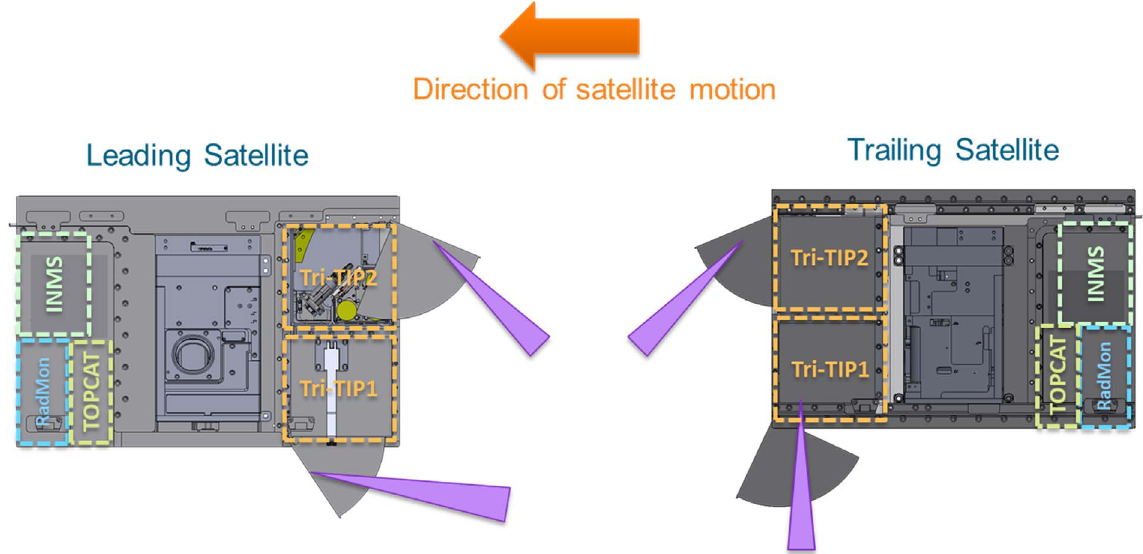
Fig. 5. Schematic layout of the CIRCE payloads within the lead and trail satellite buses. The UK ’ s IRIS suite of payloads occupies the front 2U of the leading satellite, and during night-time, the rear of the trailing satellite. The bus avionics are located in the centre 2U of each bus. The US Tri-TIP payloads occupy the rear 2U of the leading satellite, and during night-time, the front of the trailing satellite. This enables the Tri-TIP instruments to image the same volume of the ionosphere to support tomographic reconstruction. (Adapted from Nicholas et al., 2019, their Fig.